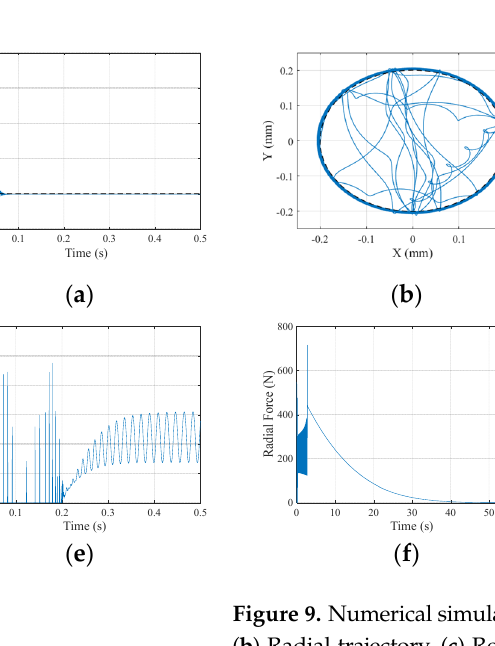
Figure 8. Numerical simulation results of the rotor touchdown at 10,000 r/min: ( a ) Axial displacement, ( b ) Radial trajectory, ( c ) Rotor speed change in the first 0.5 s, ( d ) Rotor speed change for the whole process, ( e ) Radial contact force of the TDB in first 0.5 s, ( f ) Radial contact force of the TDB for the whole process, ( g ) Temperature change in first 0.5 s, ( h ) Temperature change for the whole process. The speed was further increased to 20,000 rpm, and the simulation results are shown in Figure 9. The change in whirl speed showed that the whirl speed remained at 6240 r/min and did not increase with increasing rotor speed, unlike when the speed was 10,000 rpm. In addition, the contact force and heat generation level at the beginning of the drop further increased as the rotor speed increased. The radial maximum contact force was 1155 N. The maximum temperature rise of the rolling element was 10.5 °C. After entering the stable forward whirl motion, the contact force and heat generation did not change much compared to the lower speed, where the contact force was approximately 200 N.